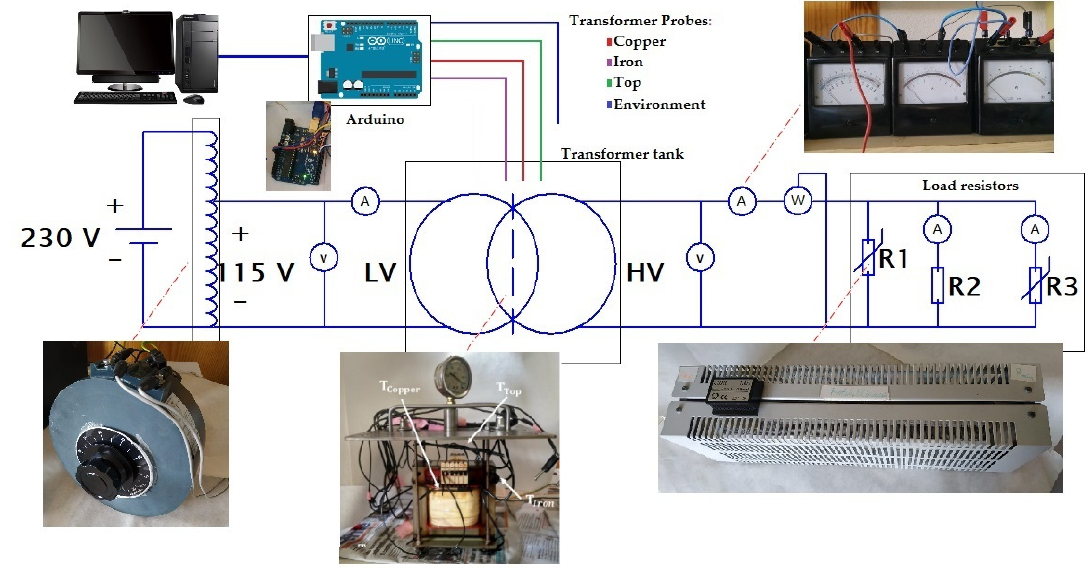
Figure 2. Connection scheme of the experimental platform.